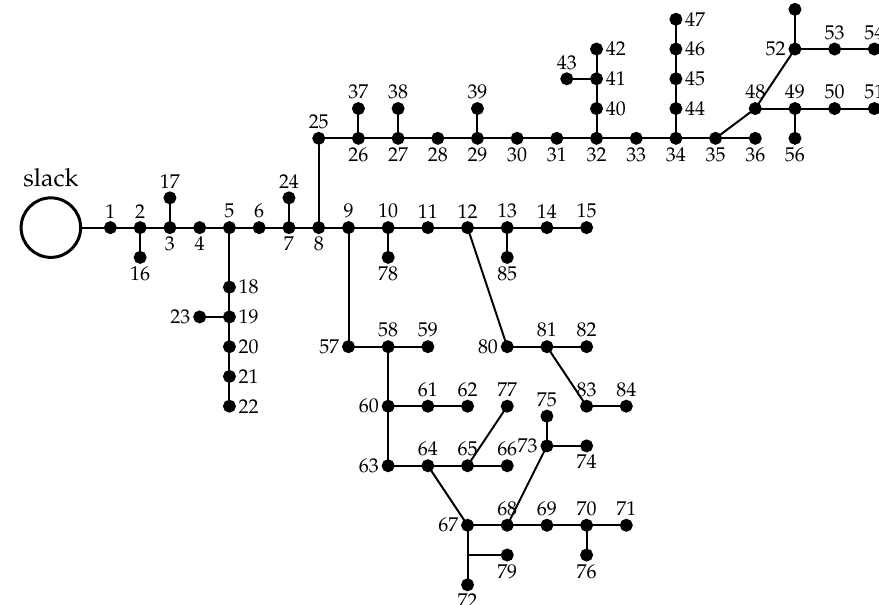
Figure 1. Grid topology of the IEEE 85-bus system for monopolar power flow